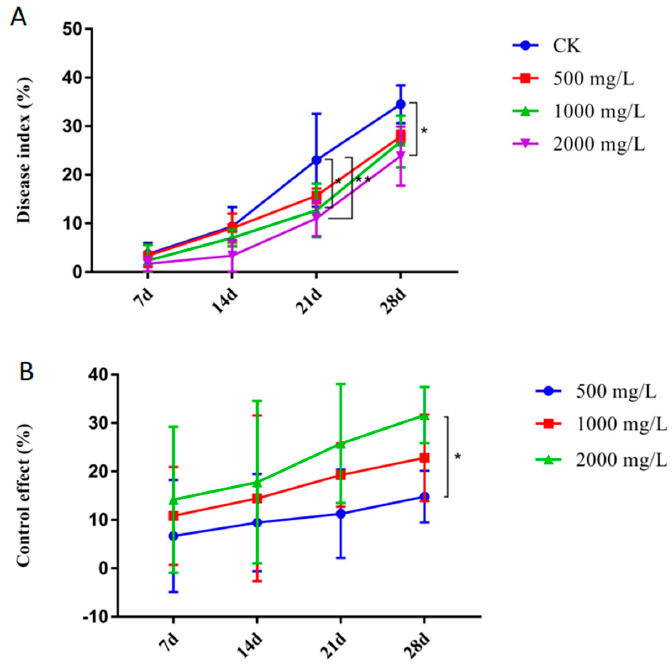
Figure 1. Disease index values ( A ) and control effects ( B ) in sugarcane with leaf scald disease at 7, 14, 21, and 28 d after inoculation with Xa . Plants were treated with one of two different Cu(OH) 2 concentrations. Data are presented as the mean ± standard error ( n = 3). * indicated significance with p ≤ 0.05 (ANOVA and Tukey’s HSD) and ** indicated significance with p ≤ 0.01 (ANOVA and Tukey’s HSD).